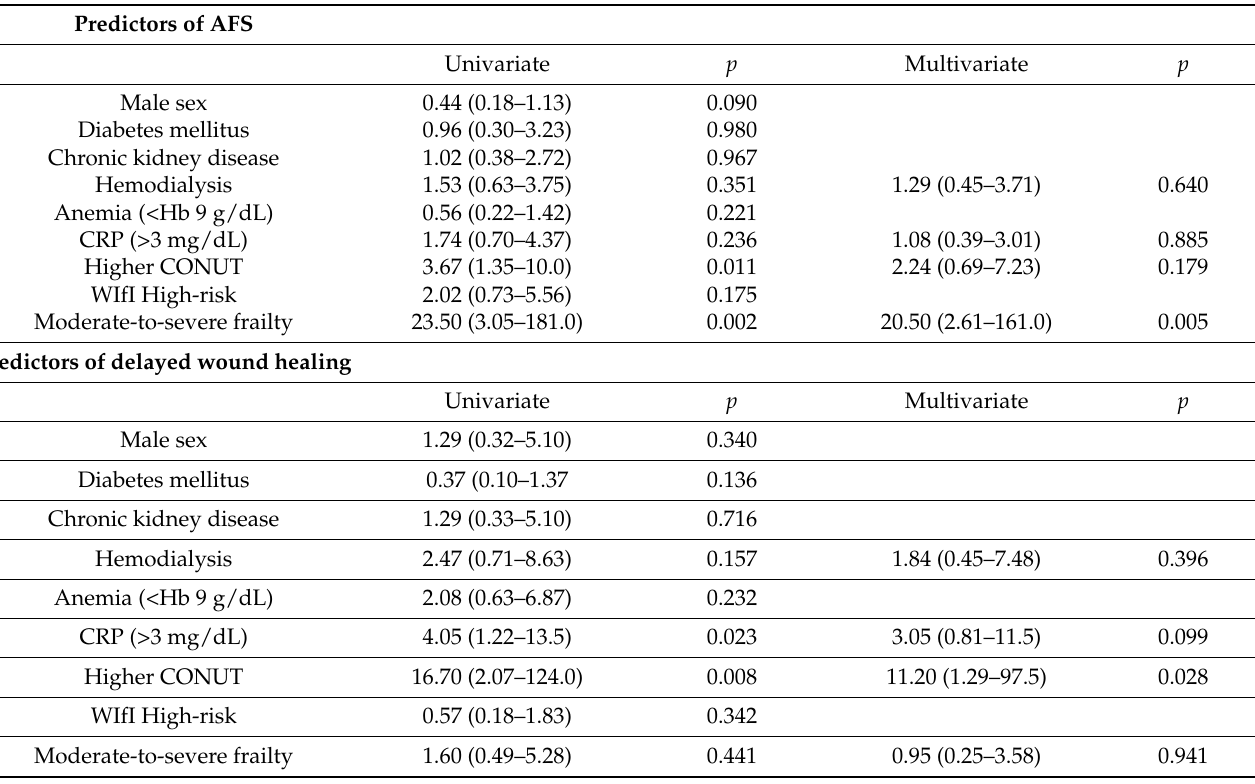
Table 4. Univariate and multivariate logistic regression analyses of AFS and delayed wound